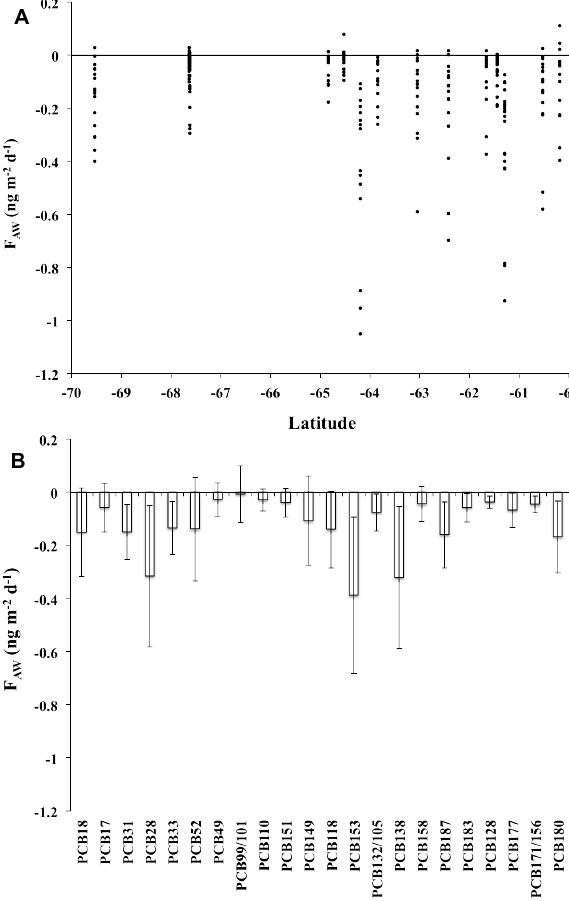
Fig. 5. Air-water exchange of PCBs. Net diffusive air-water ex- change (ngm − 2 d − 1 ) fluxes during the ESSASI and ATOS II cruises versus latitude (A) , and congener-specific diffusive fluxes for the Southern Ocean (B)